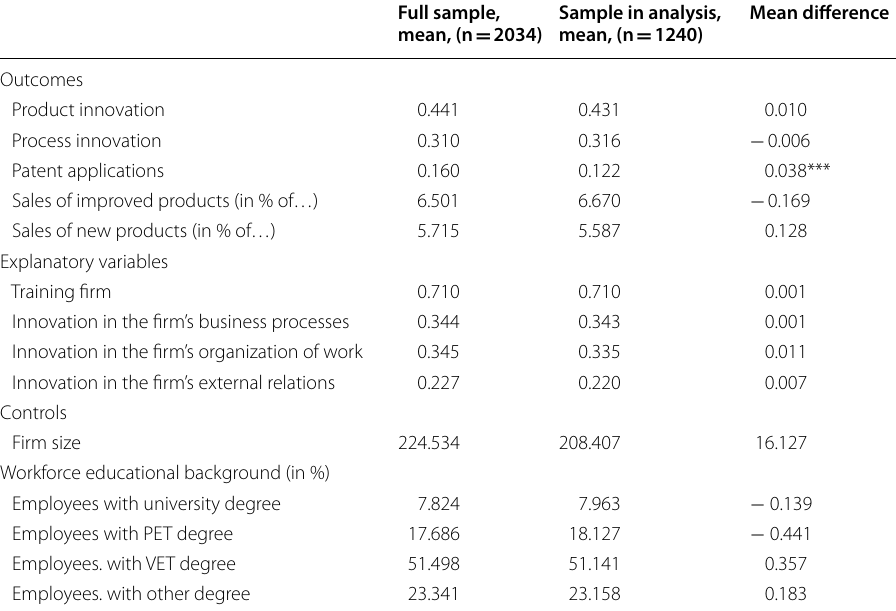
Table 4 Comparison of estimation sample with full